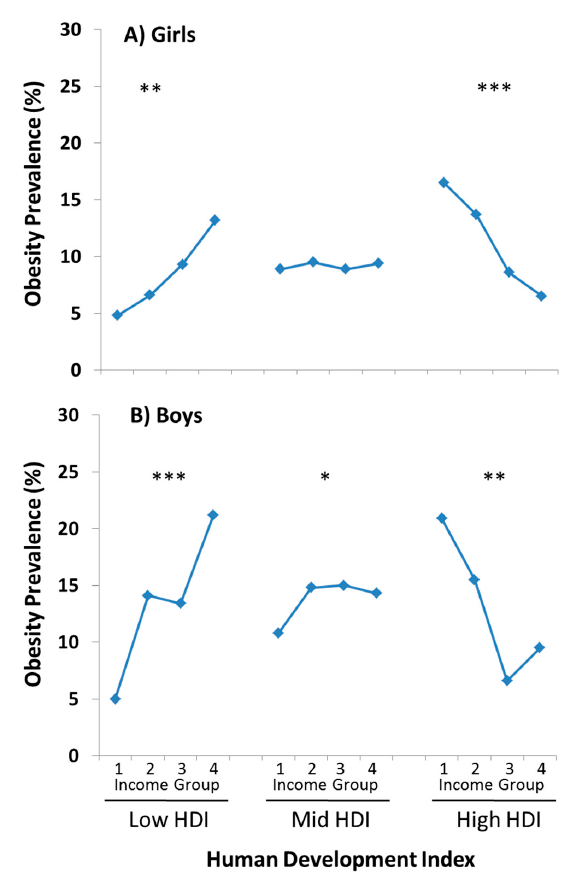
Figure 2. Income gradients in obesity prevalence across levels of HDI in ( A ) girls and ( B ) boys from ISCOLE. Low, middle and high human development index (HDI) correspond to the 10th, 50th and 90th percentiles of the ISCOLE sample (HDI = 0.52, 0.72 and 0.91, respectively). Tests for linear trend are indicated: * p < 0.05; ** p < 0.001; *** p < 0.0001. Figure is adapted from Broyles et al.